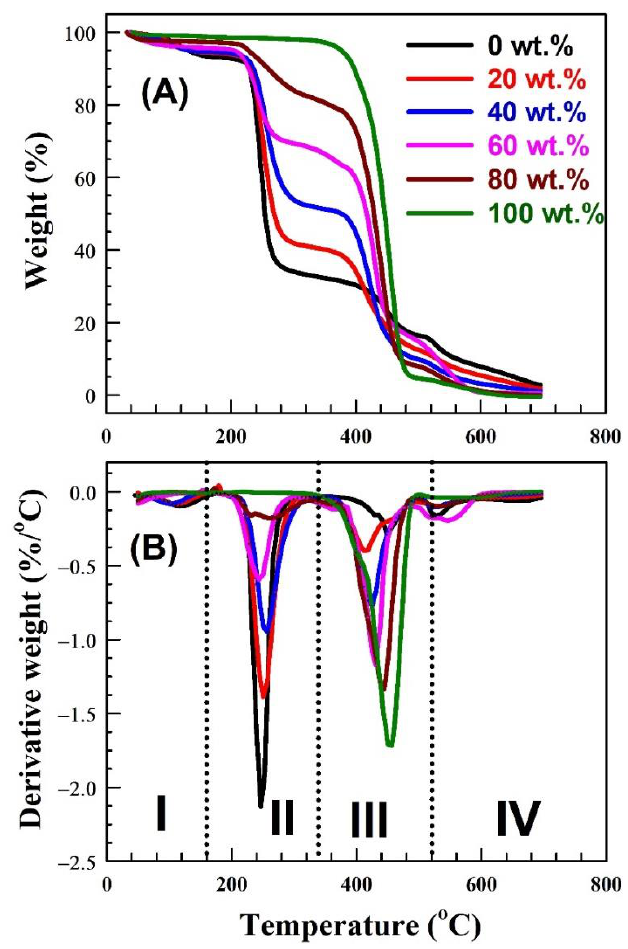
Figure 2. ( A ) Thermogravimetric analysis (TGA) and ( B ) the derivative thermogravimetric (DTG) for poly(vinyl alcohol) (PVA) blended with different concentrations of Nylon-6,6.